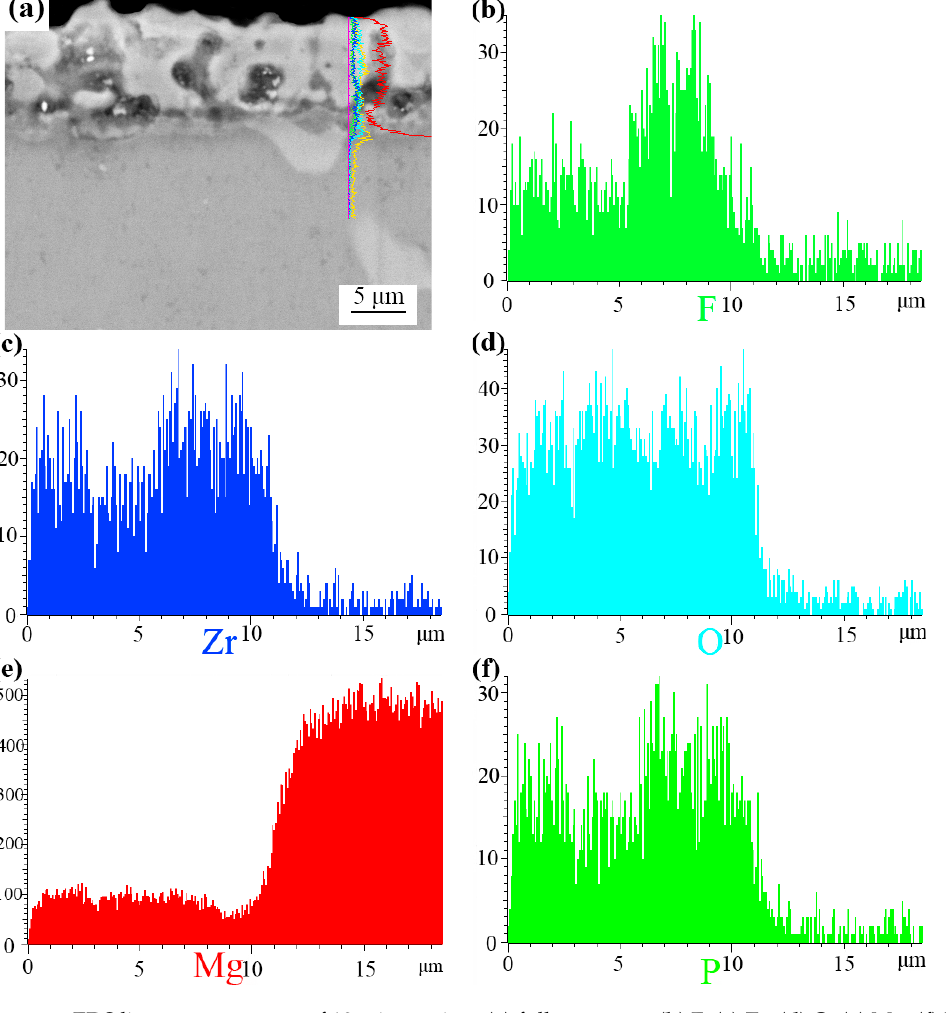
Figure 5. EDS line scan spectrum of 10 min coating: ( a ) full spectrum; ( b ) F; ( c ) Zr; ( d ) O; ( e ) Mg; ( f ) P.